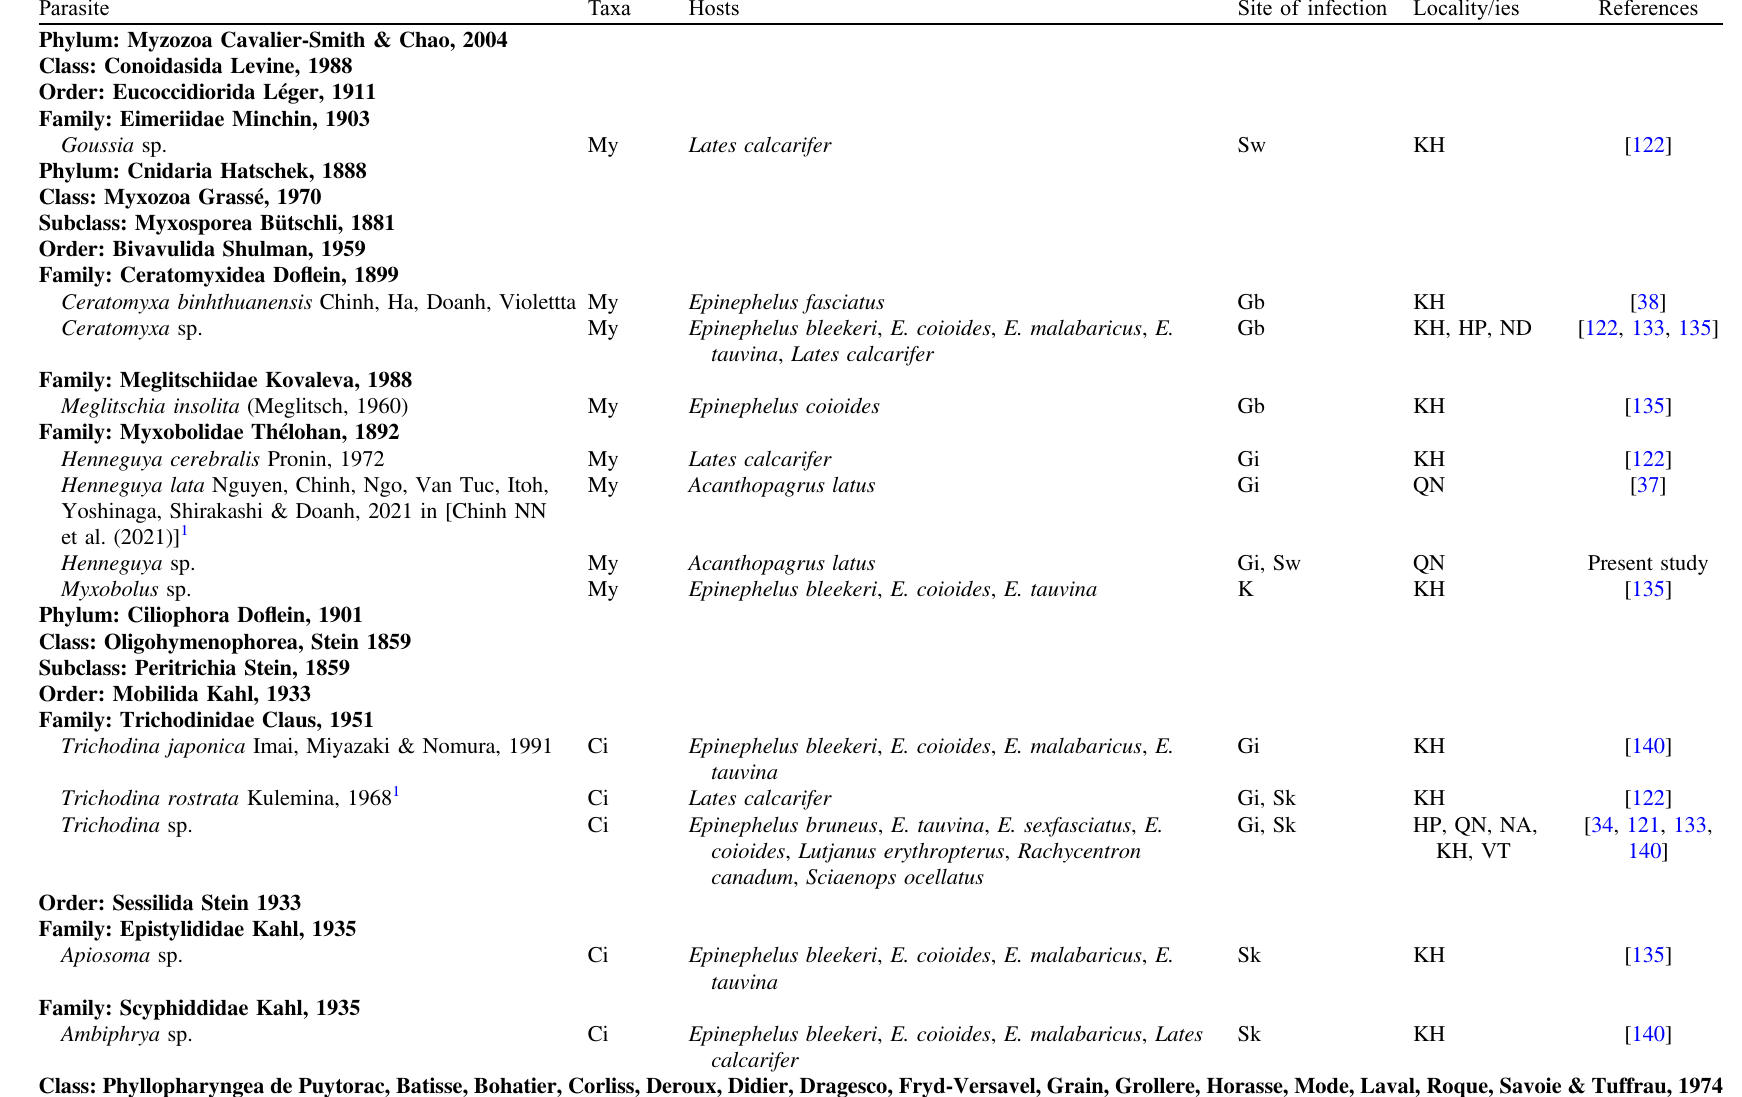
Table 2. List of marine fi sh parasites in Vietnamese waters. Parasite Taxa Hosts Site of infection